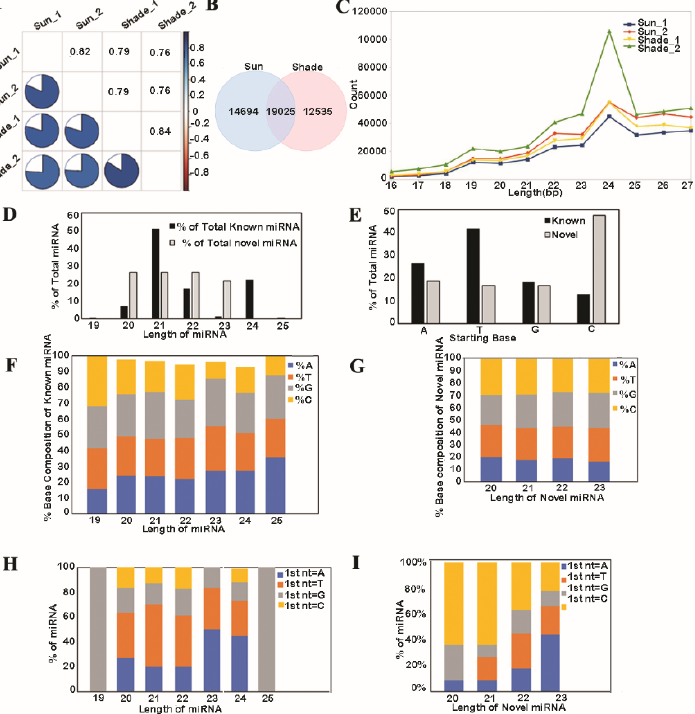
Figure 1. Analysis of known and novel miRNAs expressed under prolonged shade in SP. ( A ) Correlation plot analysis for the aligned sequences among the 4 libraries. ( B ) Venn diagram representation of control and test replicates’ reads that were aligned to the genome. ( C ) Length distribution of known miRNA from the 4 small RNA libraries. ( D ) Length and percentage of known and novel miRNAs. ( E ) Frequency of the first nucleotide bias of the mature miRNA. Percentage of total base composition of the ( F ) known and ( G ) novel miRNA. Percentage base composition of the first nucleotide in the ( H ) known and ( I ) novel miRNA.